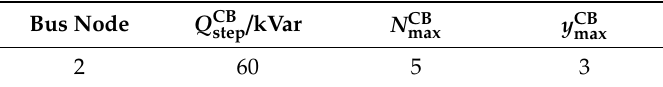
Figure 4. The modified IEEE 33-node hybrid AC / DC distribution network. Table 1. Parameters of capacitor bank.